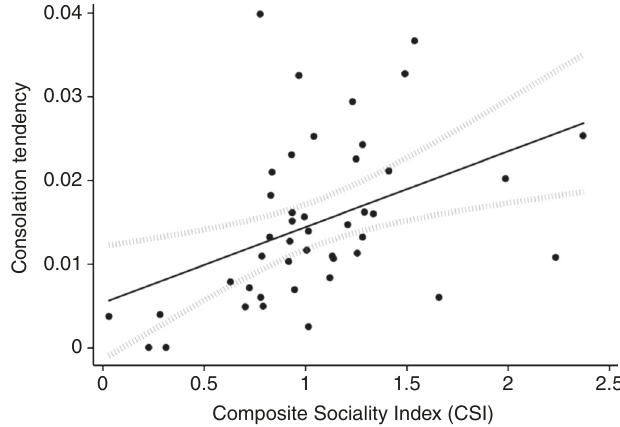
illustrates, we found a signi fi cant positive correlation between consolation tendency from earlier to later age-classes (Pearson ’ s r (20) = 0.61, P = 0.002), indicating relative consistency over the lifespan. This relation corresponds to an intra-class correlation (ICC) of 0.61 (95% con fi dence interval: 0.27, 0.82; F(21, 21) = 4.1, P < 0.001).